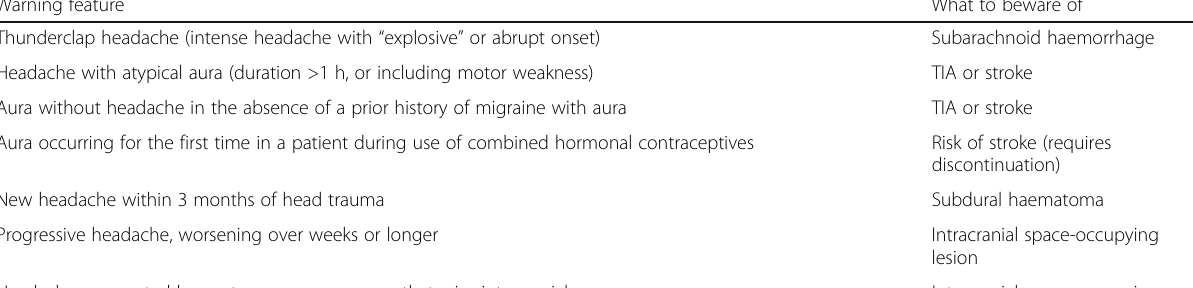
Table 5 Specific warning features ( “ red flags ” ) in the history Warning feature